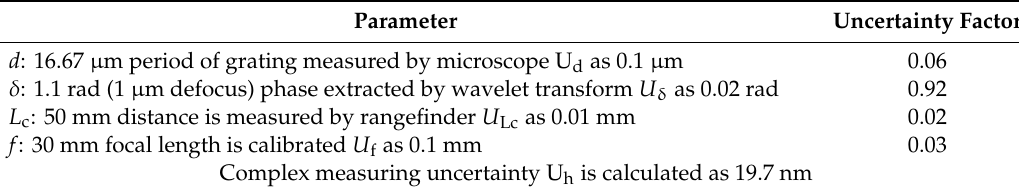
Table 1. Measurement uncertainty in the